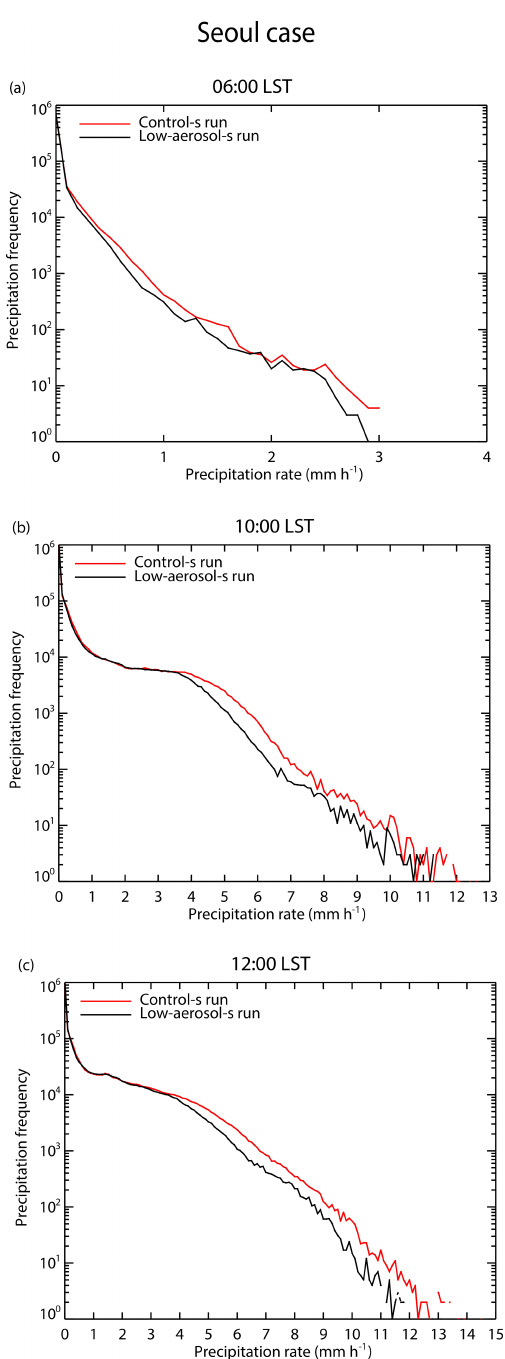
Figure 5. Cumulative frequency distributions of the precipitation rates at the surface in the control-s and low-aerosol-s runs for the Seoul case at (a) 06:00LST, (b) 10:00LST and (c)